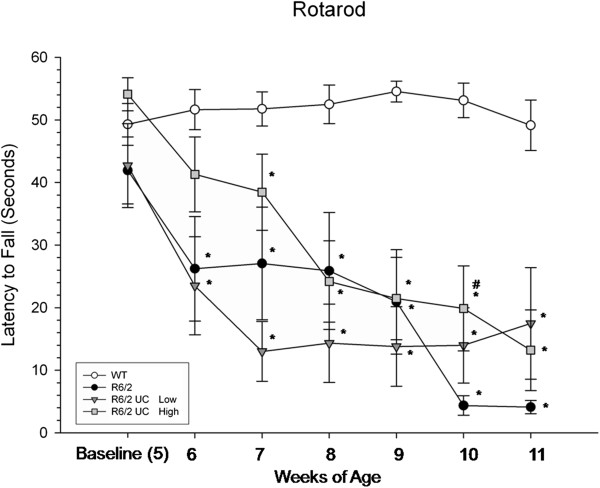
Motor coordination assessment of R6/2 mice following umbilical cord mesenchymal stem cell (UC MSC) transplantation. A significant decline in motor coordination was observed in untreated R6/2 mice when compared to WT mice. The R6/2 mice that received transplantation of high-passage UC MSCs displayed significantly longer latencies to fall, compared to untreated R6/2 mice at ten weeks of age. (Note: *significant from WT; #significant from R6/2; †significant from high-passage UC MSCs). Line graph represents mean value; error bars represents SEM. SEM, standard error of the mean; WT, wild type.